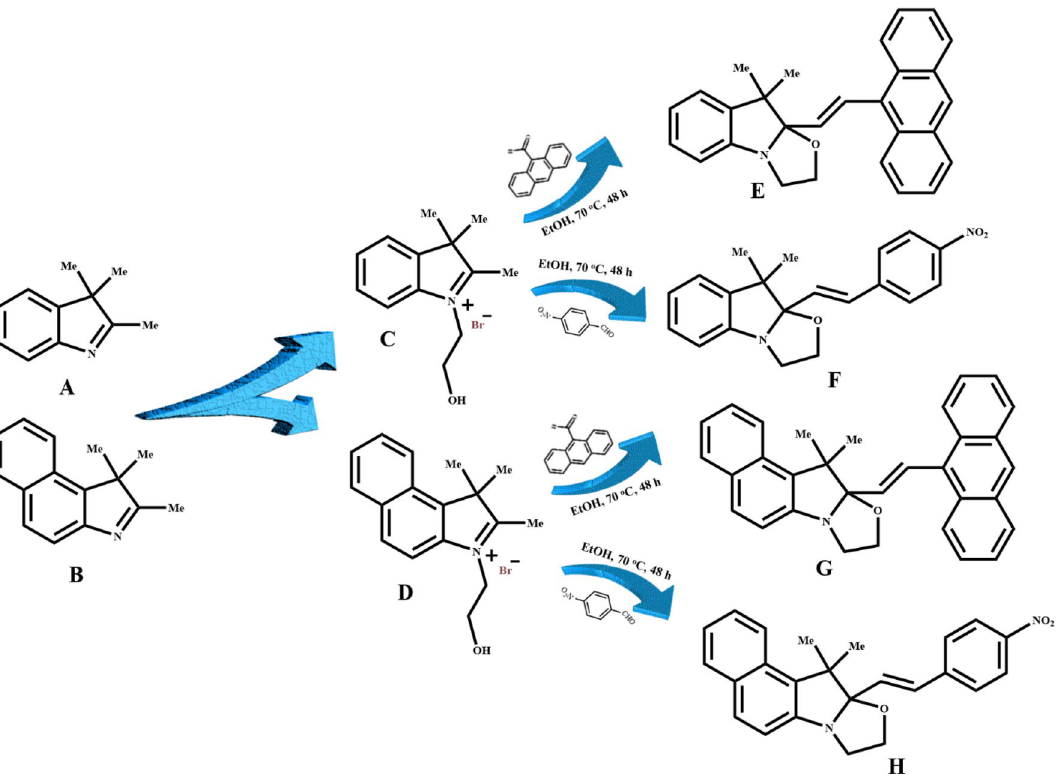
Figure 1. Schematic representation for the synthesis of different oxazolidine derivatives from various indolium